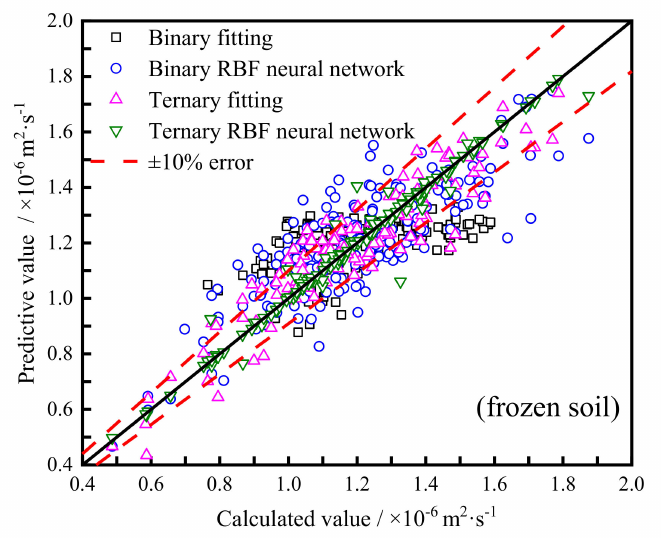
Figure 14. Comparison of prediction results of thermal diffusivity of frozen soil.